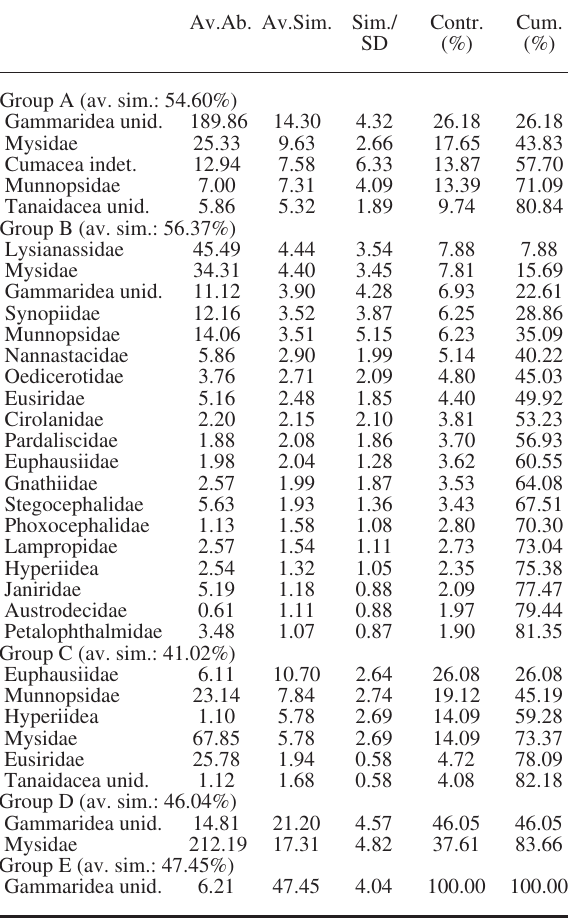
Table 5. – results of simPer analysis. average similarity within groups. Families are ranked according to their average contribution to similarity within the five stations groups a-e discriminated by the multivariate analysis of the 35 sampling stations. a cut-off at a cumulative similarity of 80% was applied to the data analysis. unid: unidentified; av.ab.: average abundance; av.sim.: average similarity; sim./sd: ratio similarity/standard deviation; Contr.(%): percentage contribution to total similarity; Cum.(%): percentage of cumulative similarity.